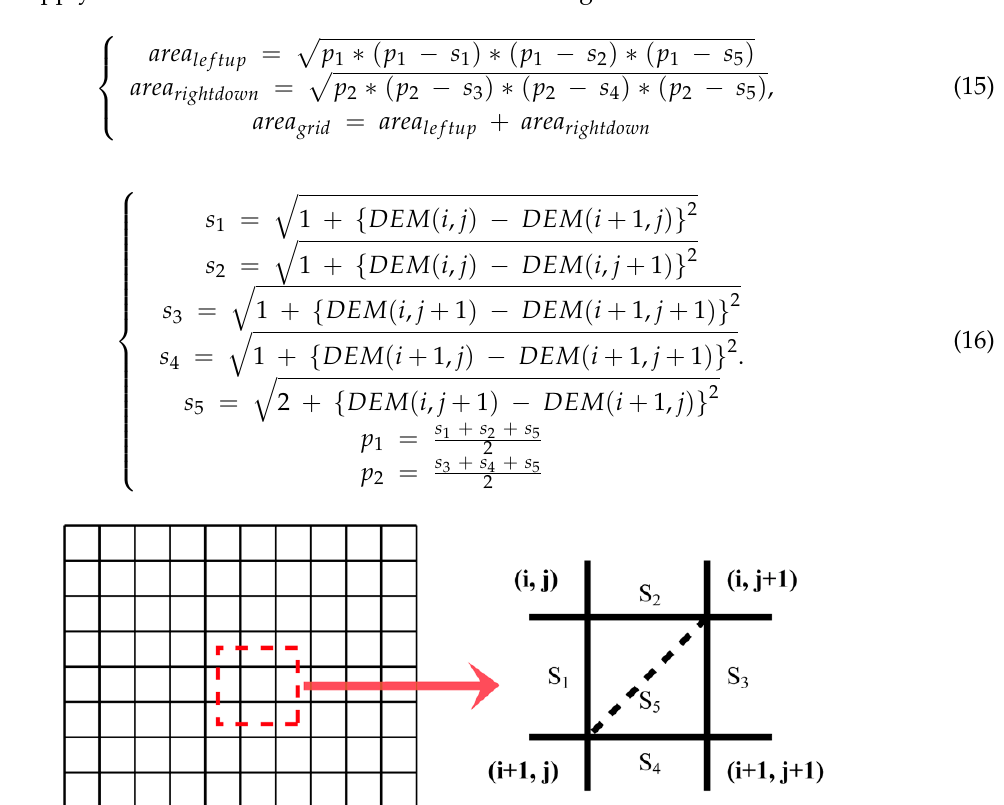
Figure 3. Diagram to show the algorithm in a DEM grid. On the left the DEM is expressed as raster data, while the image on the right shows one certain DEM grid where the top left corner is ( i , j ). This grid is further divided into two triangles by a suppositional line s 5 . The proportions of these two triangles can be calculated using Heron’s formula: